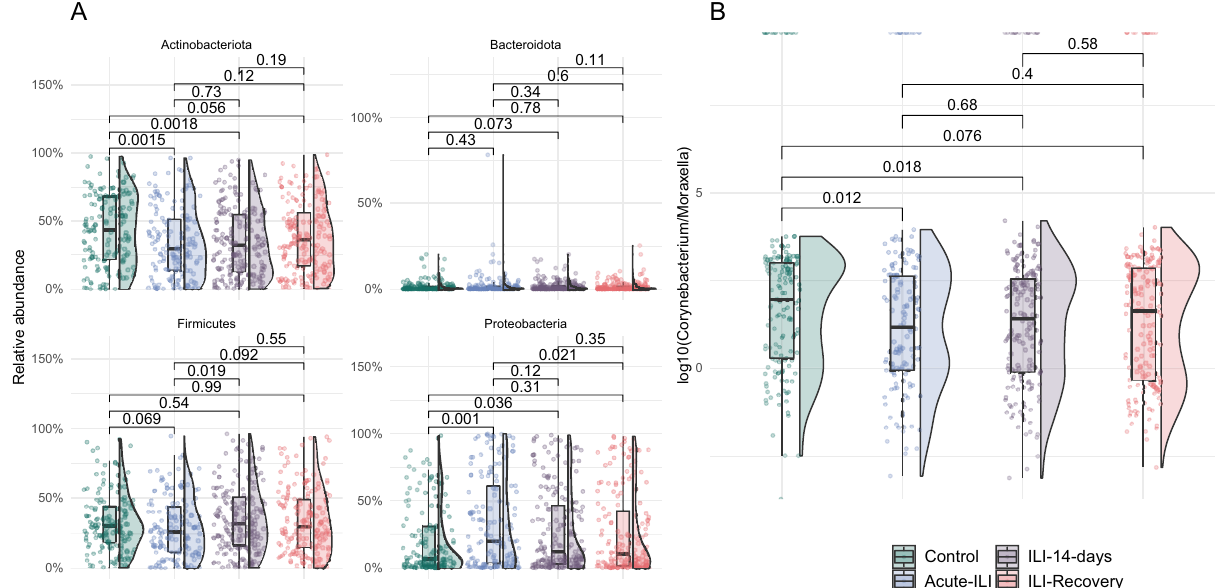
Figure 2. Comparison of phylum level abundances and Corynebacterium/Moraxella ratio. ( A ) Relative abundances of the top four phyla were compared between groups using Wilcoxon rank-sum test, corrected for multiple comparisons using Benjamini–Hochberg Procedure. ( B ) Corynebacterium / Moraxella relative abundance ratio was compared between groups using Wilcoxon rank-sum test, corrected for multiple comparisons using Benjamini–Hochberg